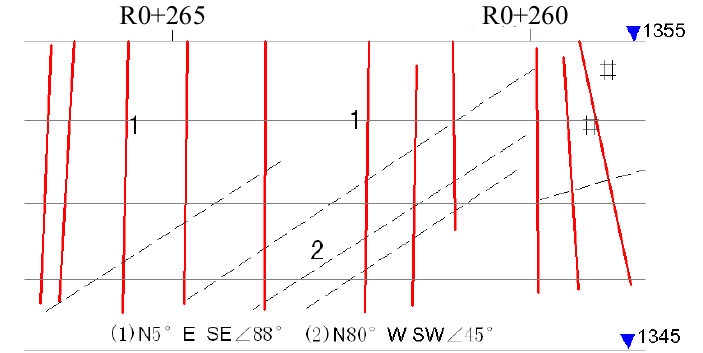
Figure 10. Joints distribution at upstream side wall of the main powerhouse. R0+265